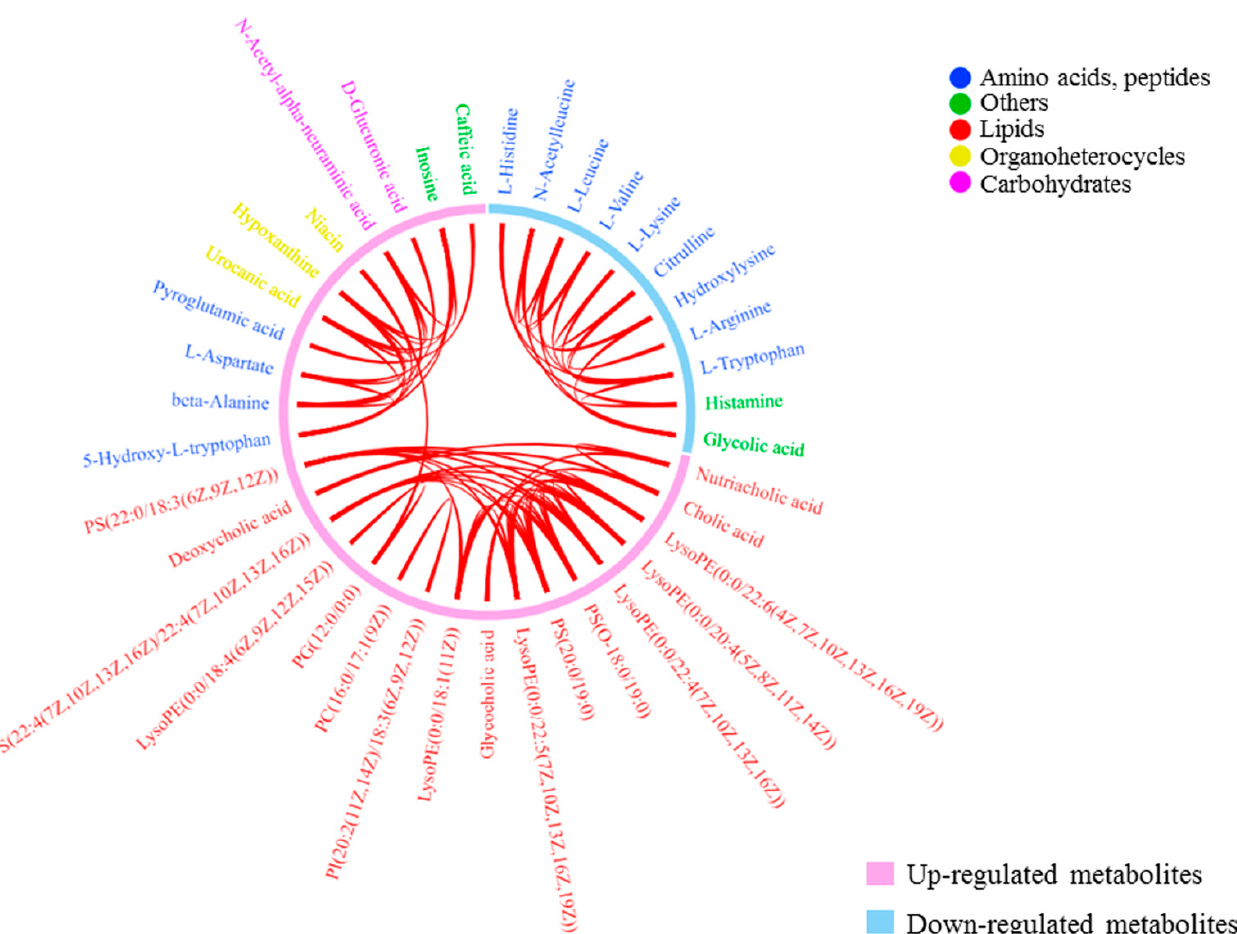
Figure 4. The pink circular arc represented up ‐ regulated metabolites, and the blue circular arc represented down ‐ regulated metabolites. Interestingly, more correlations between metabolites trended toward positive correlations. The most conspicuous correlations were lipid ‐ lipid connections and amino acid ‐ amino acid connections, which revealed unique functional clusters of co ‐ regulated metabolites including lyso ‐ phosphatidylethanolamine, phosphatidylserine, bile acids, and amino acids. Among these correlations, the correlation coefficient of N ‐ acetyl ‐α‐ neuraminic acid and inosine was highest ( R = 0.9989, P = 3.7 × 10 − 80 ), followed by L ‐ histidine and histamine ( R = 0.9847, P = 1.7 × 10 − 46 ), nutriacholic acid and cholic acid ( R = 0.9816, P = 3.8 × 10 − 44 ). Among the negative correlations, the absolute